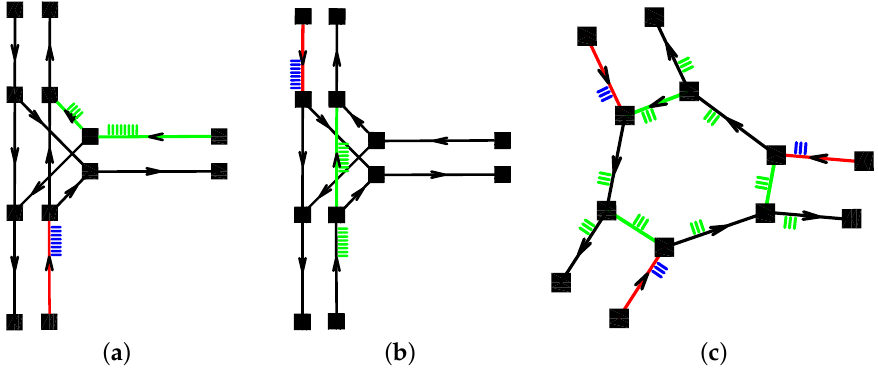
Figure 4. Crossing lane condition features. ( a ) Priority right; ( b ) Crossing a lane when turning left; ( c ) Roundabout priority